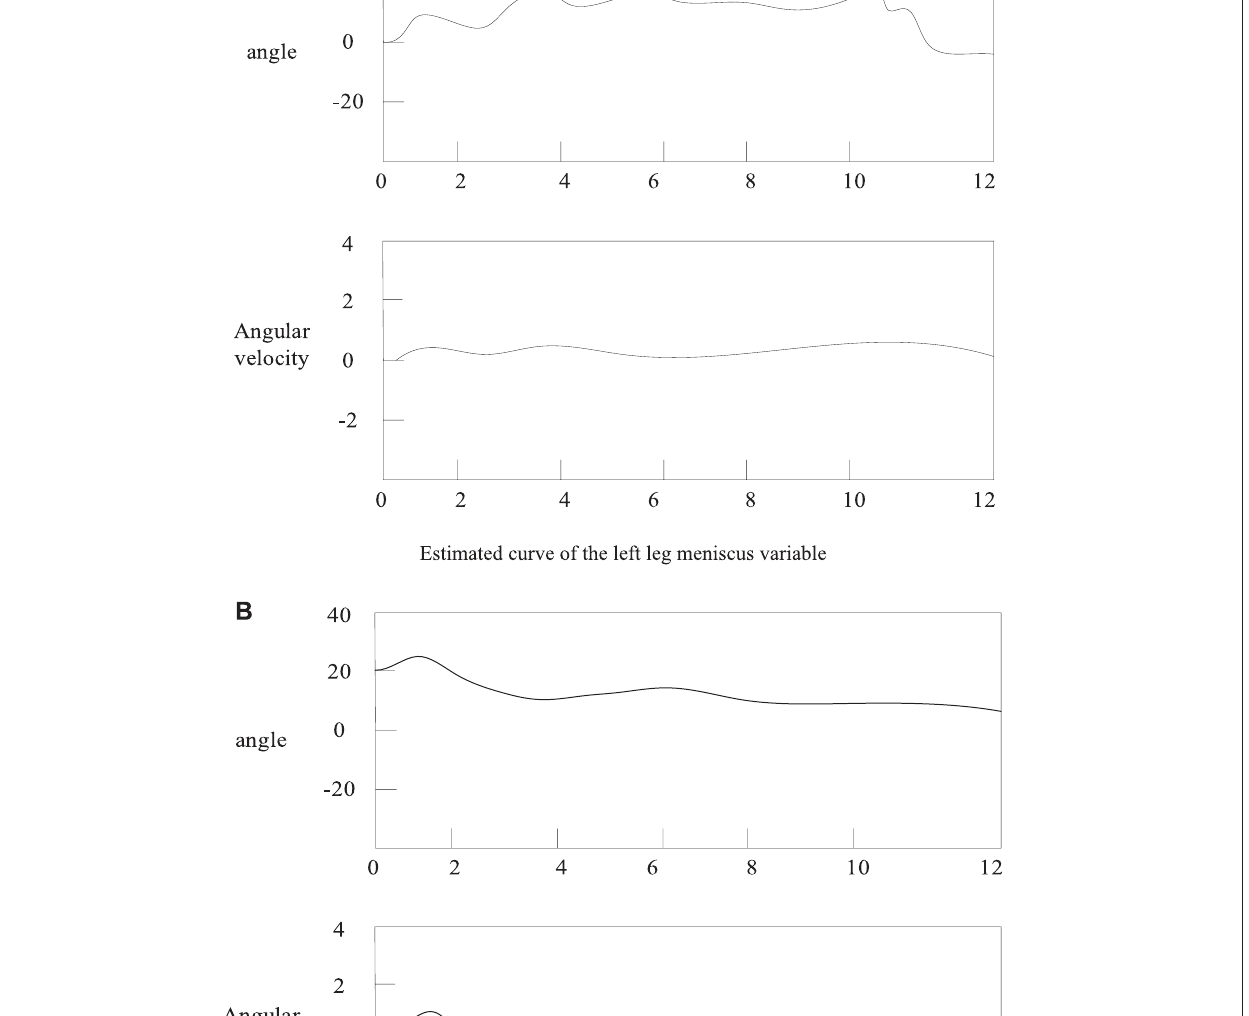
Frontiers in Bioengineering and Biotechnology |